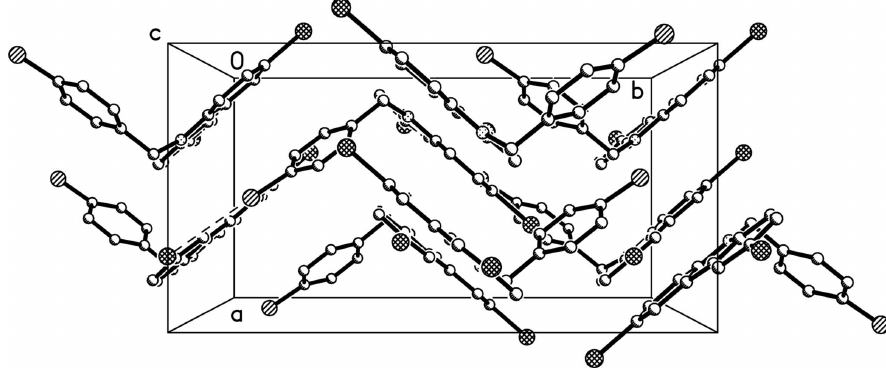
Figure 2 Crystal packing of (I), viewed down the a axis with H atoms omitted for